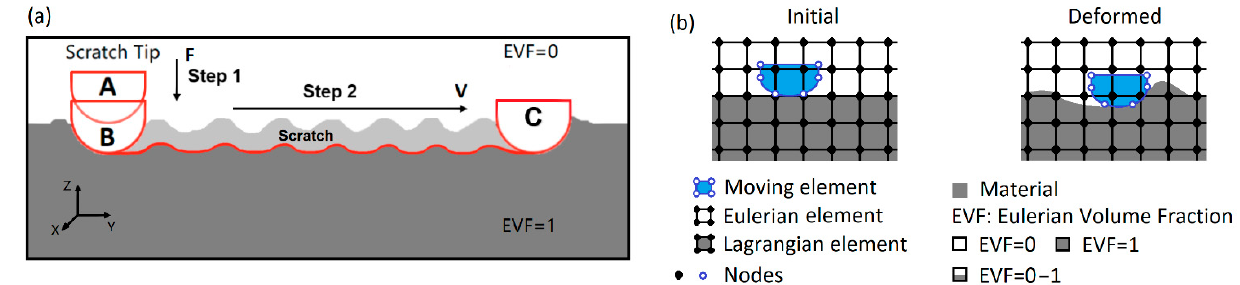
Figure 4. ( a ) Schematic of simulation model and ( b ) the concept of CEL method for scratching.